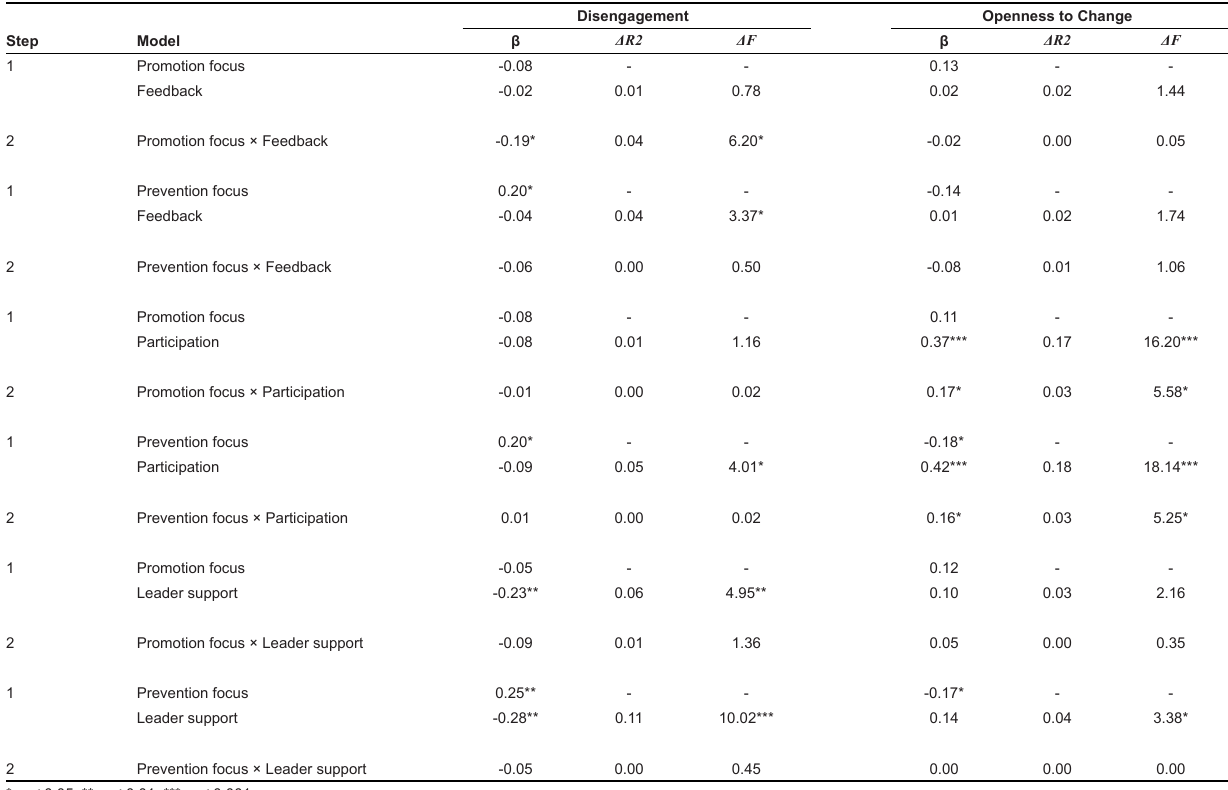
TABLE 5 Regression of disengagement and openness to change on job resources, promotion and prevention focus in sample 1 ( N = 164)